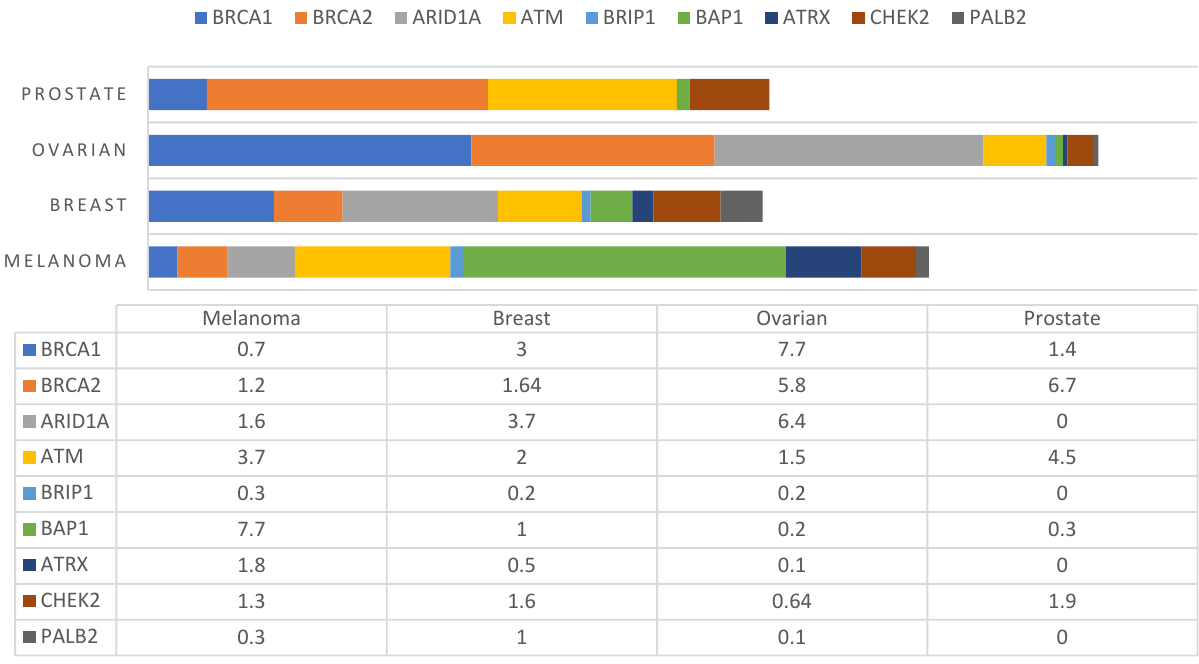
Figure 2. Prevalence of homologous recombination DNA damage repair (HR-DDR) gene mutations according to tumour lineage, in particular prostate, ovarian, breast cancer and melanoma. A total of 17,566 tumours underwent next generation testing with NGS600 to evaluate HR genes based on Heeke et al. [25].